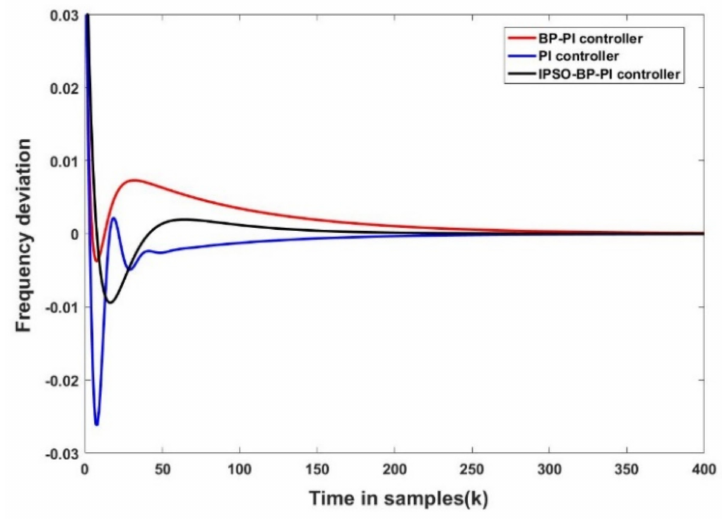
Figure 7. Dynamic responses of frequency using three strategies with DFIG-based wind turbine.